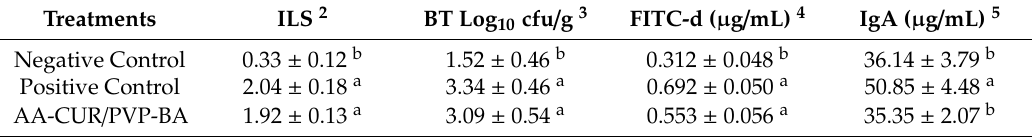
Table 6. Evaluation of a 0.1% mixture containing ascorbic acid (AA) and a solid dispersion of curcumin with polyvinylpyrrolidone (CUR / PVP, ratio 1:9) and boric acid (BA) (AA-CUR / PVP-BA) on ileum NE lesion scores (ILS), bacterial translocation (BT) to the liver, serum concentration of fluorescein isothiocyanate–dextran (FITC-d) and immunoglobulin A (IgA) levels in broiler chickens 1 . Treatments ILS 2 BT Log 10 cfu / g 3 Negative